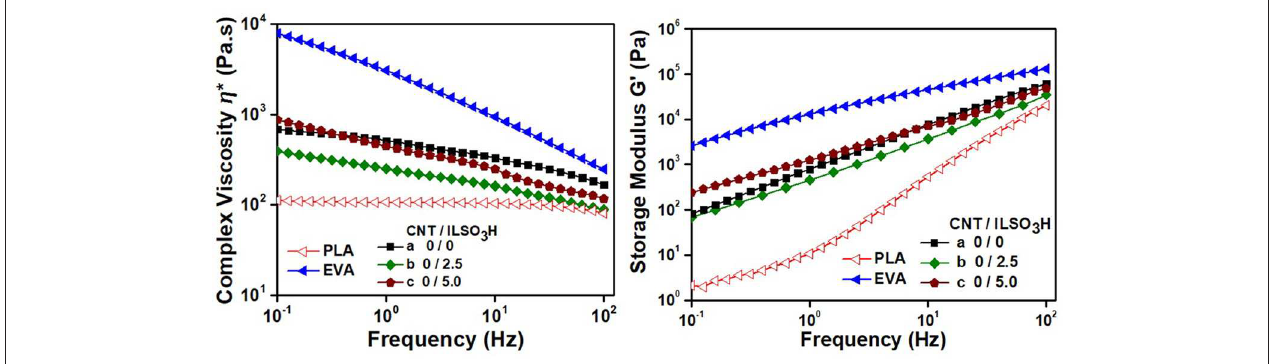
FIGURE 2 | Rheological parameters of PLA, EVA, and PLA/EVA blends loaded with CNT/ILSO 3 H in a proportion corresponding to (a) 0:0; (b) 0:2.5; and (c) 0:5.0